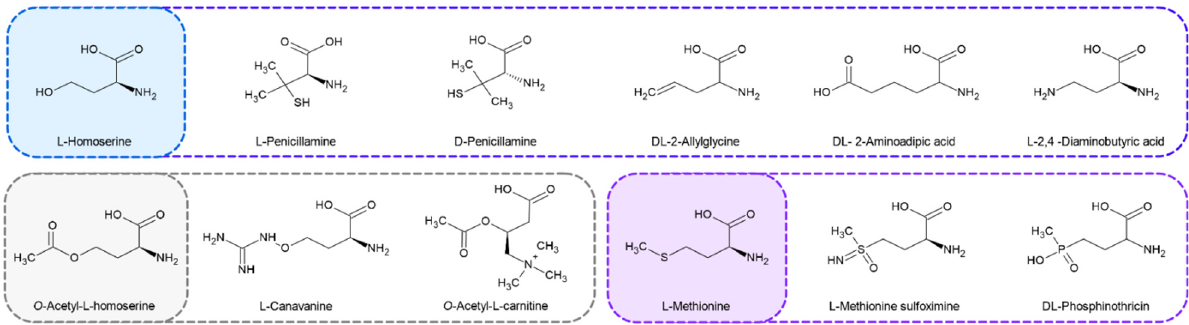
Figure 5. Structures of Ca Met2p substrate (L-homoserine), product ( O -Acetyl-L-homoserine), and the end-pathway product (L-methionine), as well as their analogs as potential inhibitors tested in this study.